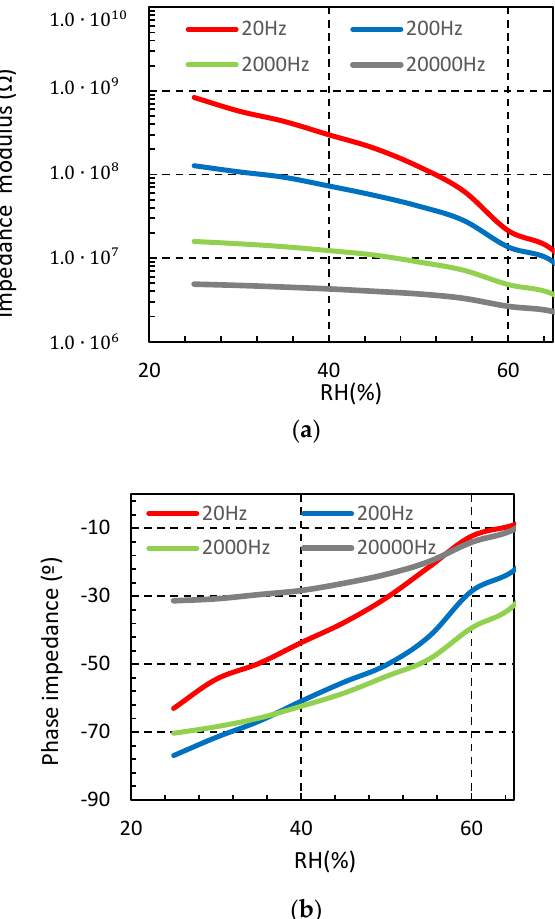
Figure 4. Measured sensor impedance from 25% to 65% relative humidity (RH) at different frequencies (T=20 °C) ( a ) impedance modulus ( b ) impedance phase.